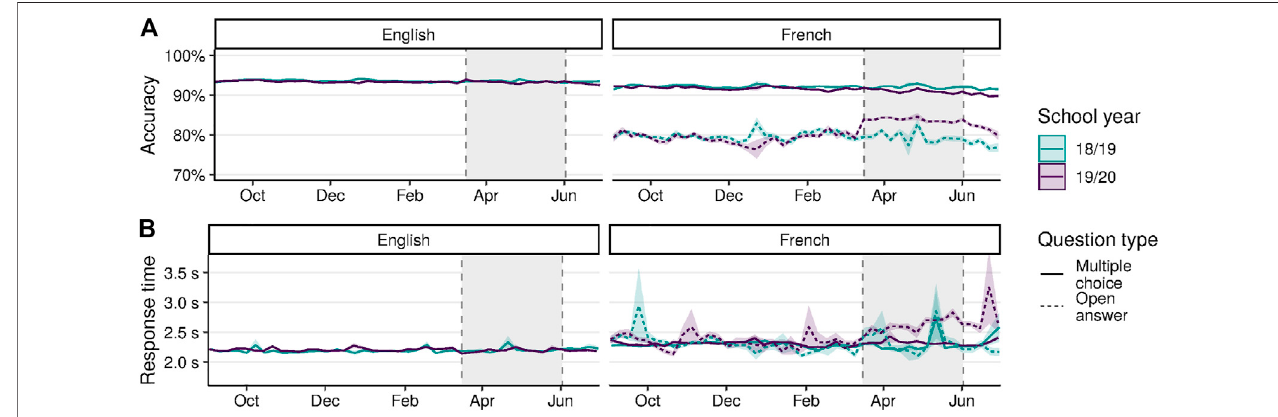
FIGURE4| Comparisonofstudyperformanceovertimeduringaregularschoolyear(18/19)andtheschoolyearaffectedbyCOVID-19(19/20). (A) Meanresponse accuracy ( ± 1 SE). (B) Mean response time ( ± 1 SE) on correct answers.